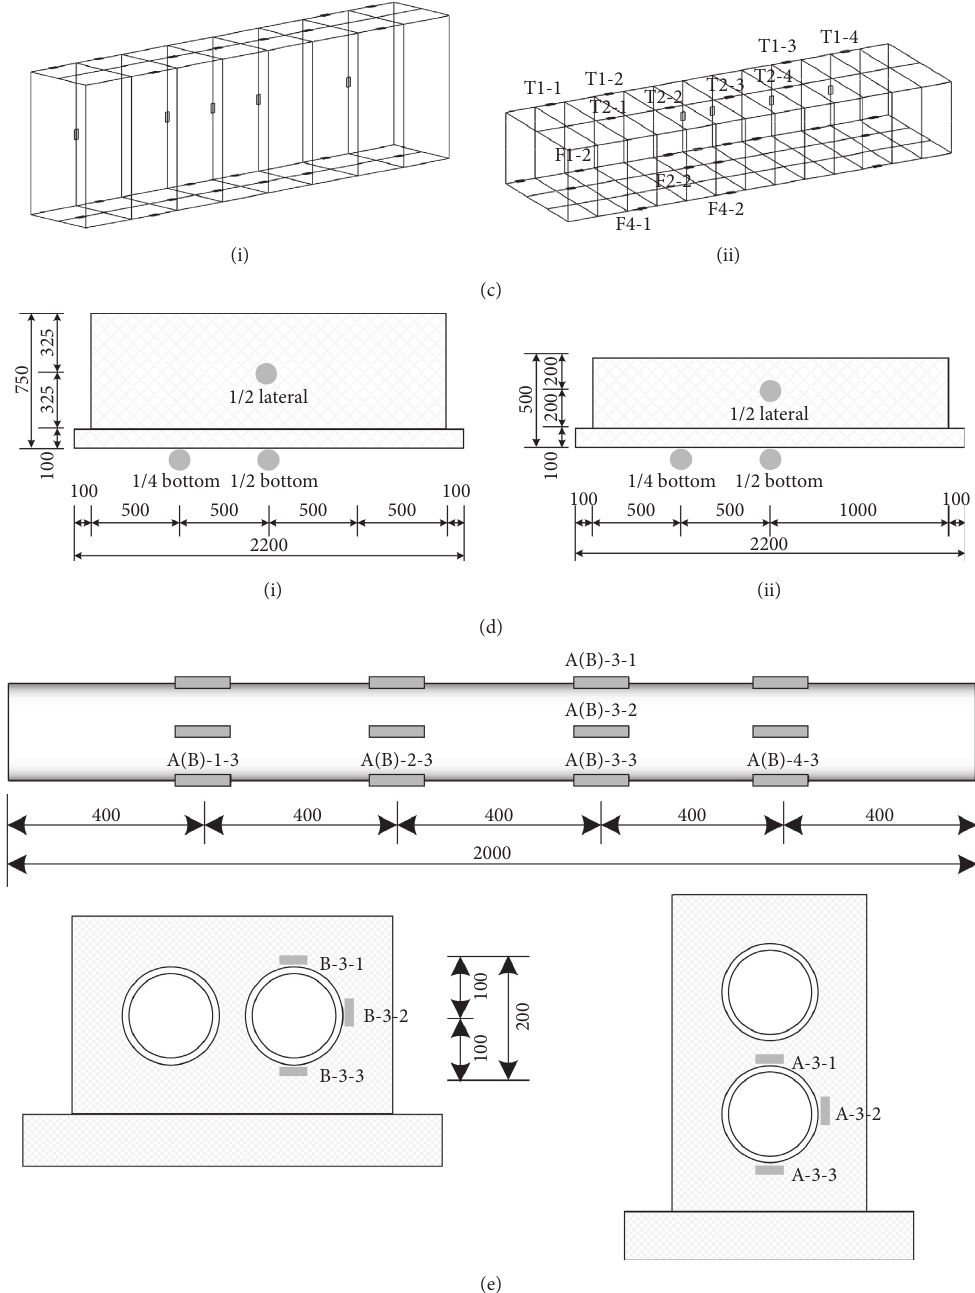
Figure 6: Specimen diagram and measurement points in the experiment (millimeters). (a) Specimen diagram: (i) A-type and (ii) B-type. (b) Cover concrete: (i) A-type and (ii) B-type. (c) Reinforcements: (i) A-type and (ii) B-type. (d) Soil pressure: (i) A-type and (ii) B-type. (e) HDPE